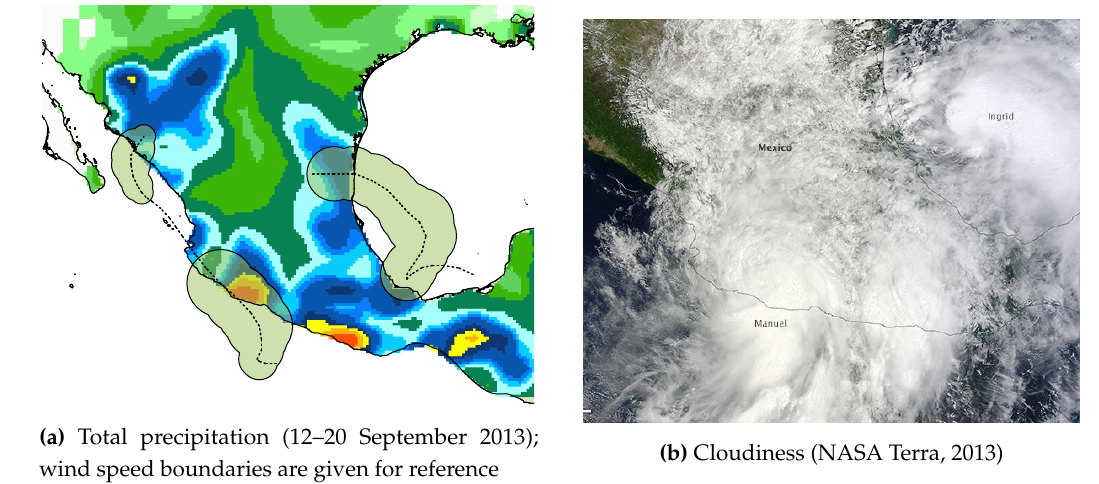
Figure 4. Representation of a disaster process (cyclones Manuel and Ingrid,